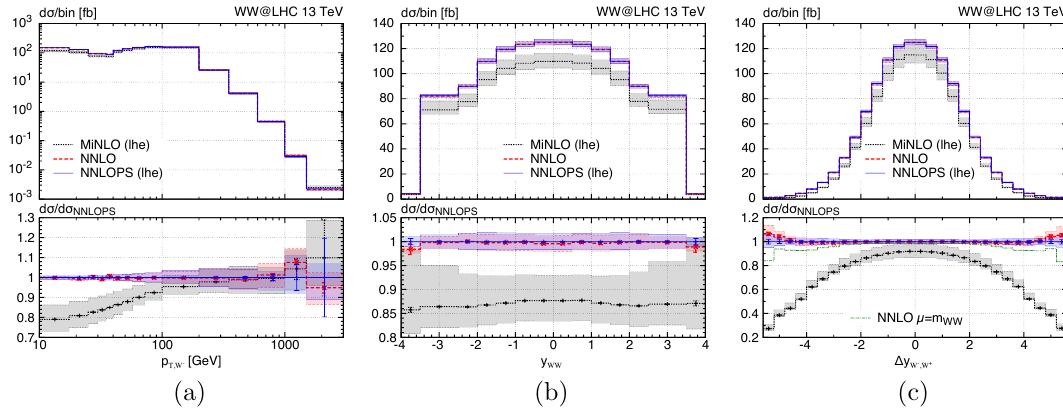
Figure 2 . Comparison at LHE level of our NNLOPS results (solid, blue) with the nominal NNLO predictions (red, dashed) for the three distributions used in the reweighting, with the binning of eq. (2.8): (a) p , (b) y and (c) (cid:1) y ; MiNLO results at the LHE level (black, dotted) WW T;W (cid:0) W + W (cid:0) are shown for reference; see text for details.